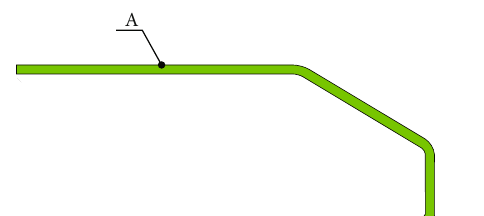
Figure 9: PSD strain contours.